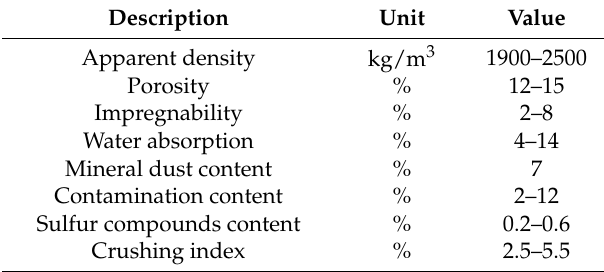
Table 1. Basic physical properties of original